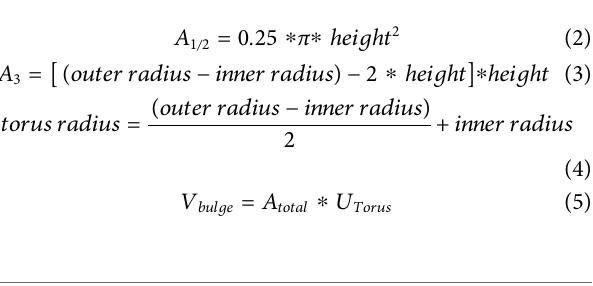
Frontiers in Physics |